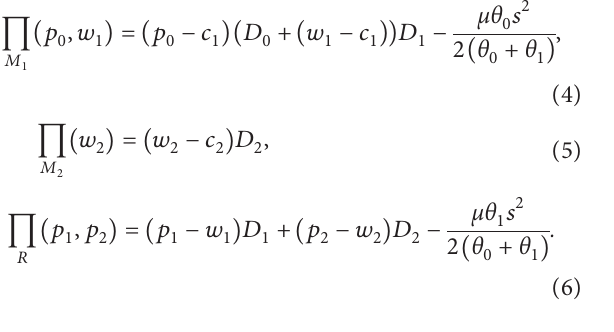
coefficient as product 1 in the traditional retail channel. The parameter k i ( i � 1 , 2 ) is always larger than other parameters , c δ , c and θ j ( j � 0 , 1 ) ; that is, the self-price sensitivity is 1 2